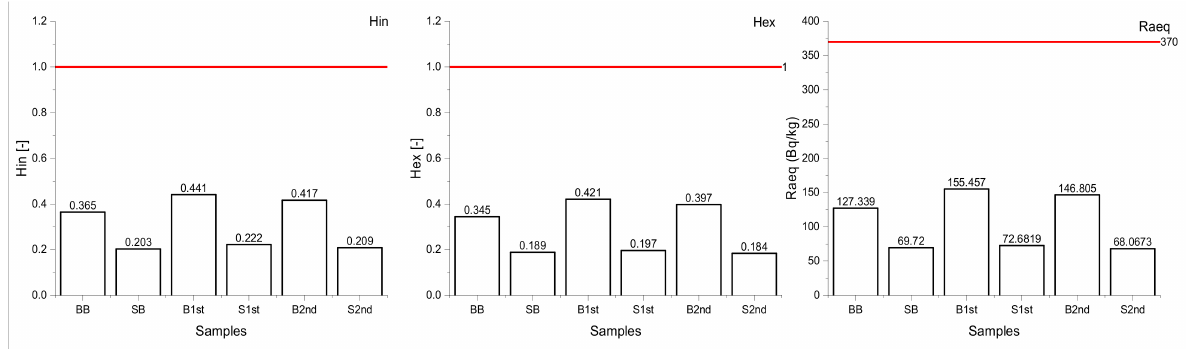
Figure 10. Comparison of the hazard indices and Ra eq with the limit values (represented by red